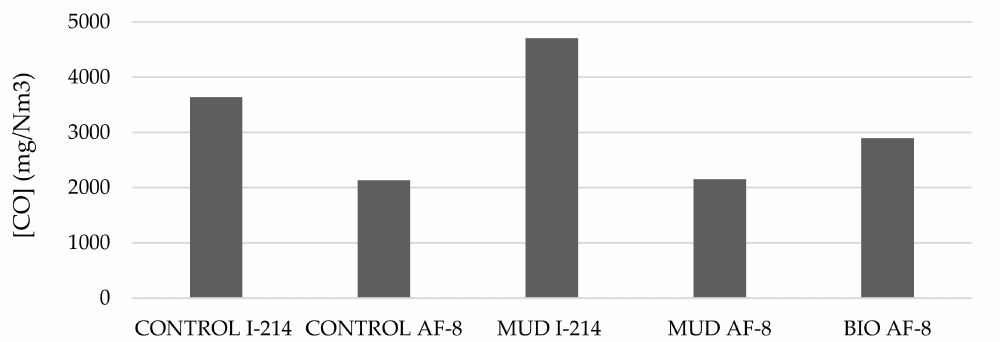
Figure 3. CO concentration in the emitted gas during